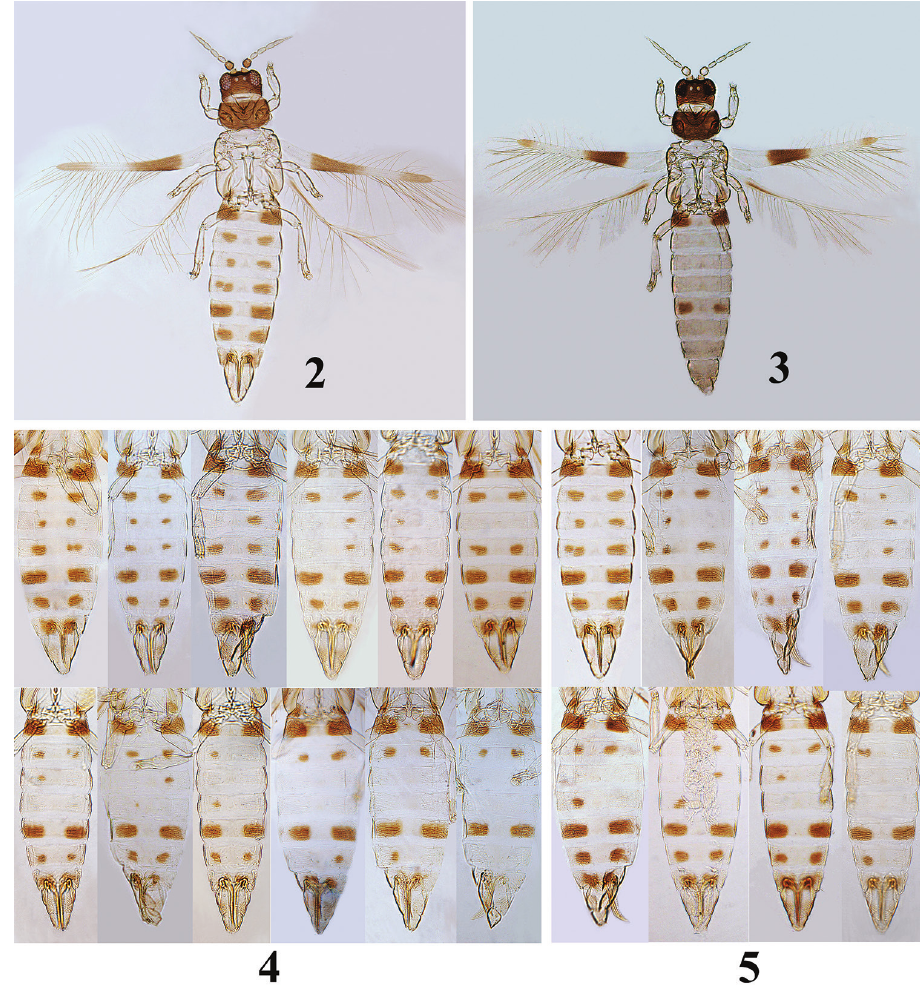
Figures 2–5. Asprothrips atermaculosus sp. n. 2 female 3 male 4 variation of colour markings on abdomi- nal tergites in “Sanming” population 5 variation of colour markings on abdominal tergites in “Chaling”